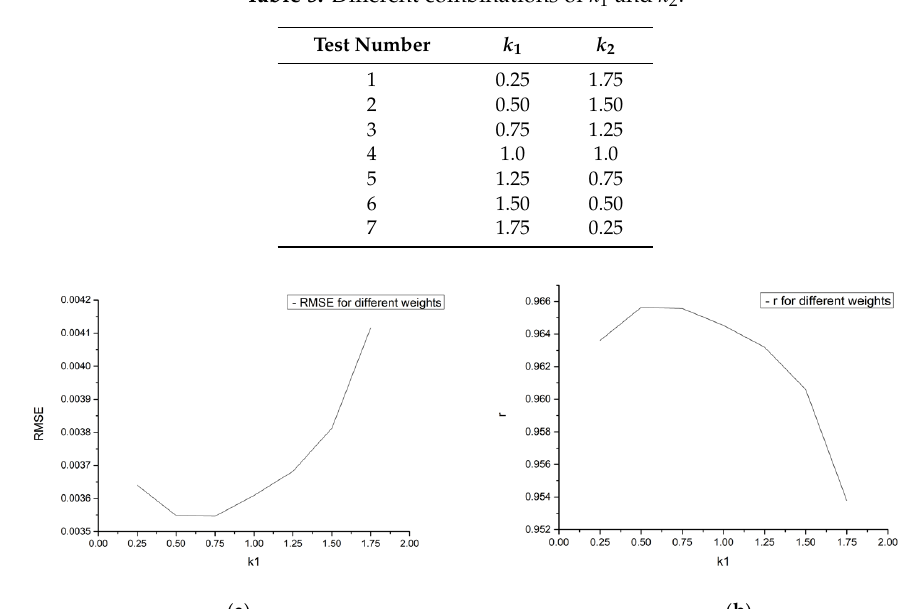
Table 5. Di ff erent combinations of k 1 and k 2 .